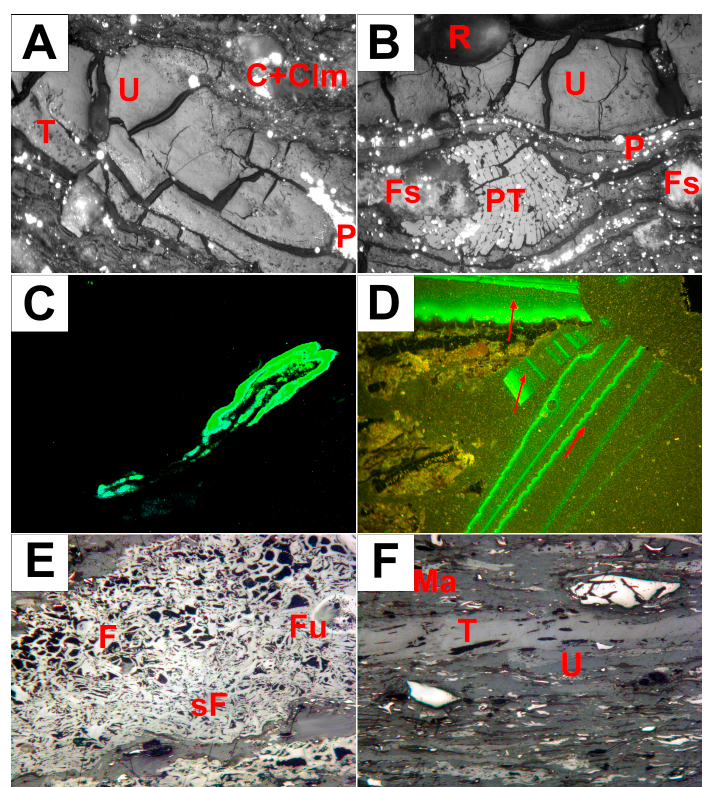
Figure 5. Petrographic nature and composition of coal in the rock. ( A ) Petrographic composition of coaly laminae (polarized reflected light, magnification 200×; T—textinite, EU—eu-ulminite, C+Clm—clay minerals and weathered feldspar, P—pyrite); ( B ) Texto-ulminite (TU), phyllo-telinite (PT), resinite (R), feldspar (Fs) (polarized reflected light) 200×; ( C ) Sporinite or alginite? (reflected, blue fluorescent, over 450×); ( D ) Animal remains in coaly shale (marked with arrows)—probably insect wings (reflected light, blue fluorescent, 200×); ( E ) Fusinite (F), semifusinite (sF) and funginite (Fu) in coaly layers enriched in organic material (polarized reflected light, 200×); ( F ) Coal in situ ventilation layers enriched with ulminite (U) and macrinite (Ma) (polarized reflected light, 450×). One of the best ways to assess the degree of coalification of altered phytogenic material is the measurement of the random reflectance of eu-ulminite B. Due to their genetic origin, ulminite layers in the shales enable precise assessment of their degree of coalification. Important statistical parameters for the distribution of the random reflectivity of coal are presented in Table 2. They Table 2. The major statistical parameters of the coal reflectogram. indicate the normal distribution of the reflectogram (Gaussian curve). The average random reflectance of eu-ulminite B from several coal samples is 0.39% with a standard deviation (stdv) of 0.03%. The petrographic composition of the coaly shales is presented in Table 3.